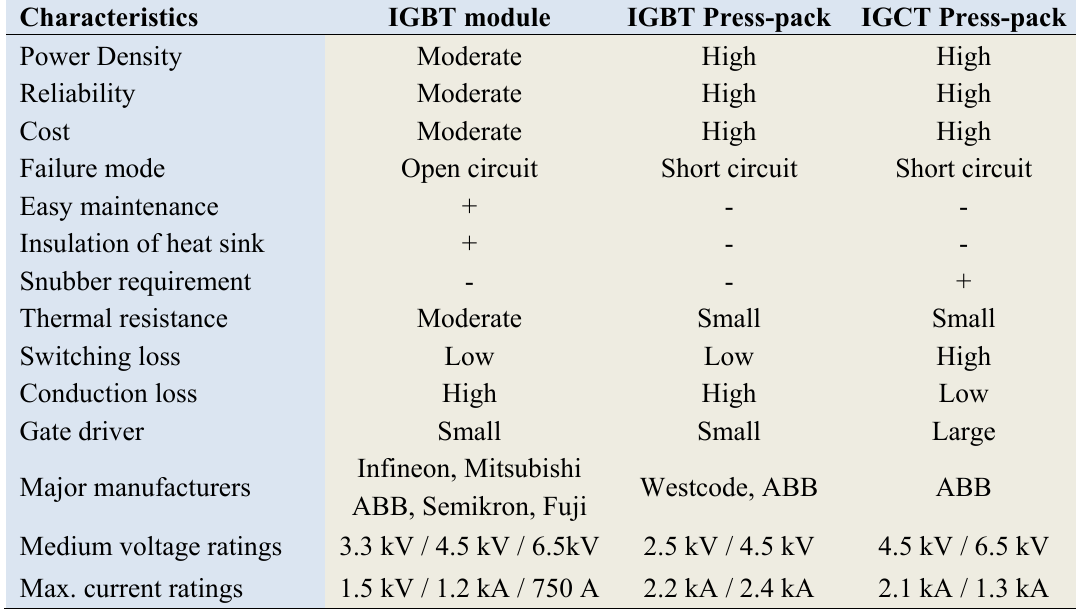
Table 1. Dominant power switching devices for modern wind power